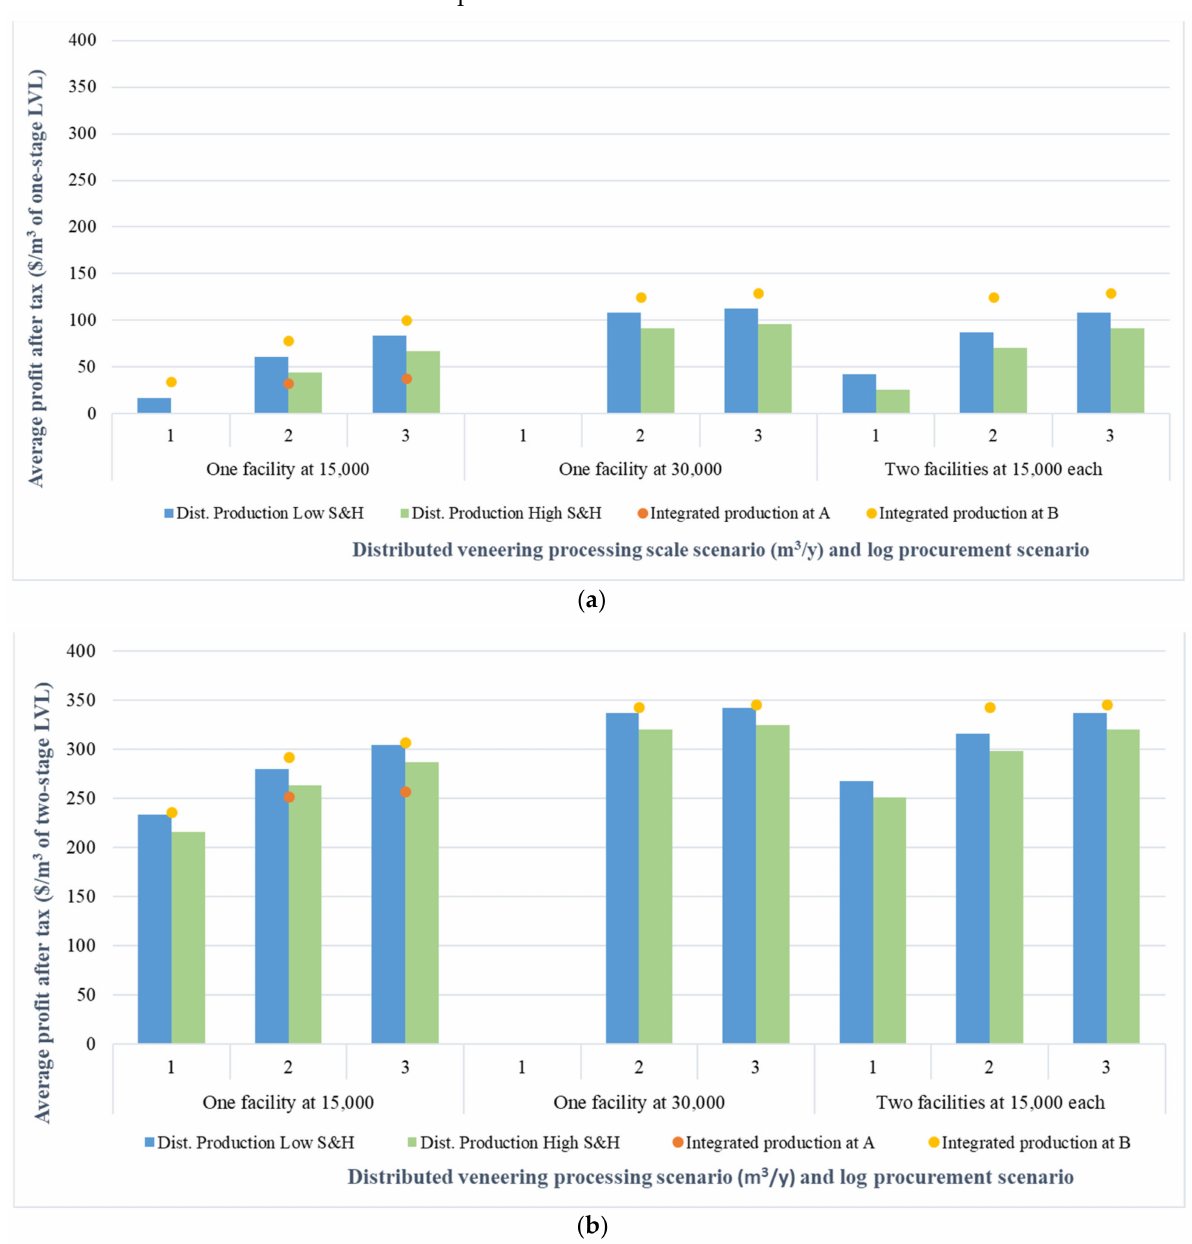
Figure 6. After-tax profit of distributed production for ( a ) one-stage and ( b ) two-stage LVL. Note: High S&H was $40/m 3 of dry veneer. Low S&H was $20/m 3 of dry veneer. Missing bars and dots indicate scenarios that were not technically